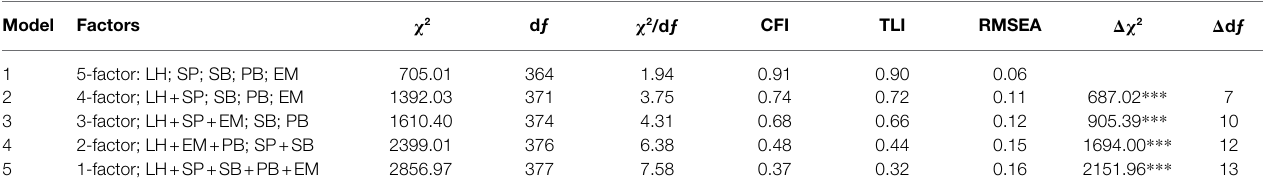
TABLE 1 | Confirmatory factor analysis of variables. Model